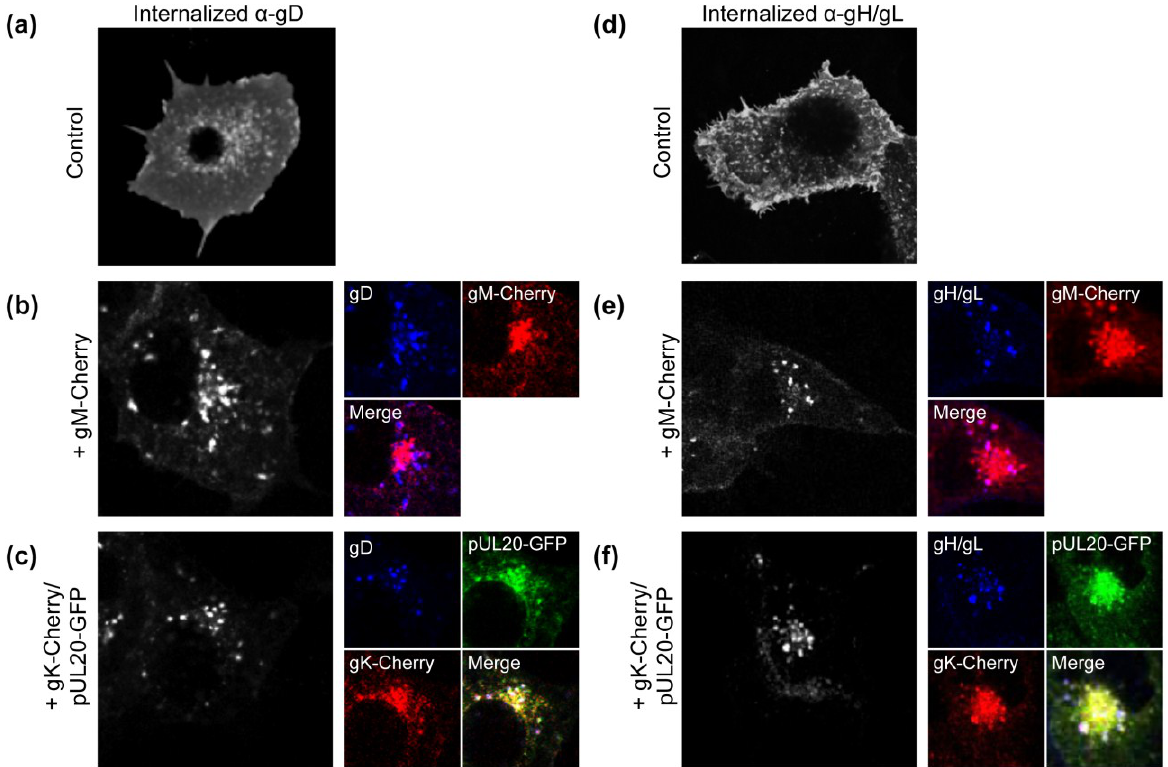
Figure 1. Effect of gK/pUL20 on the internalization of gD and gH/gL. COS-7 cells were transfected with plasmids expressing gD ( a – c ) or gH/gL ( d – f ); together with plasmids expressing GFP plus Cherry ( a,d ); gM-Cherry plus GFP ( b , e ); or gK-Cherry plus pUL20-GFP ( c,f ). At 24 h post-transfection, cells were incubated with gD or gH/gL specific antibodies for 1 h at 37 °C before being fixed, permeabilised and stained with secondary antibody. For clarity, gD and gH/gL signals are shown in black/white in the first column, followed by smaller images of gD and gH/gL signals shown in blue in the second column along with the co-expressed proteins as